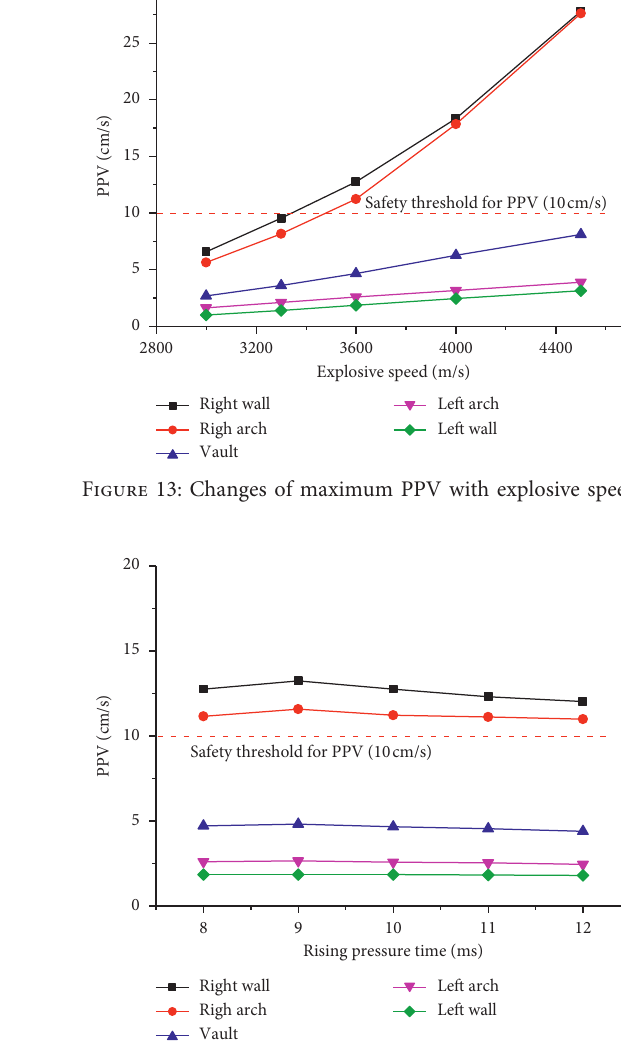
Figure 14: Changes of maximum PPV with rising pressure